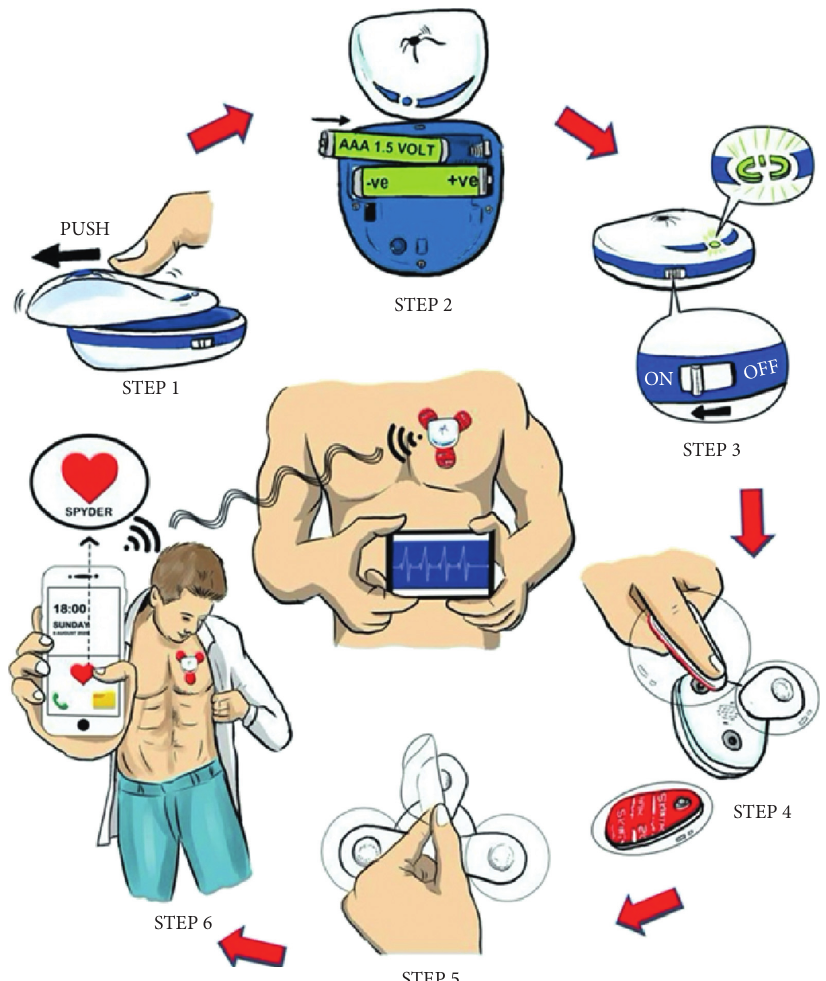
Figure 1: Instructions for usage of the Spyder ECG-monitoring